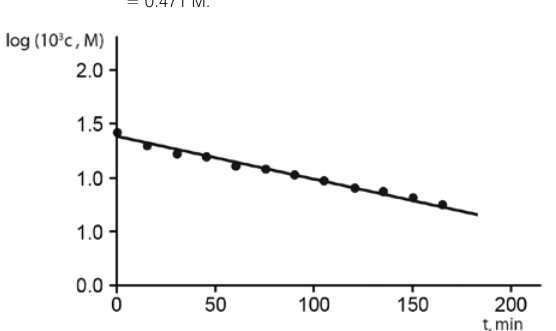
Figure 2. Typical first order plot for the reaction of phenylmagne - sium bromide ( 1a ) with phenyl tosylate ( 2 ) in THF: tolu- ene (7:10) at 90 o C; c= [PhOTos] . [PhMgBr] = 0.560 M, t [PhOTos] = 0.026